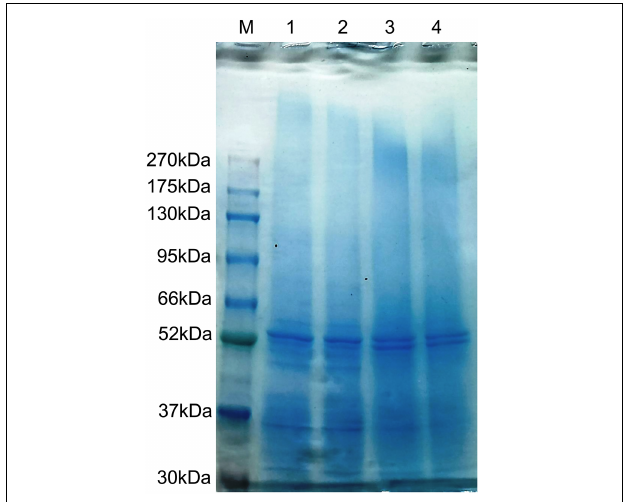
FIGURE 1 | Sodium dodecyl sulfate-polyacrylamide gel electrophoresis 12% proteins of the Porphyra dentata samples (M, marker; 1–2, first harvest; 3–4, fifth